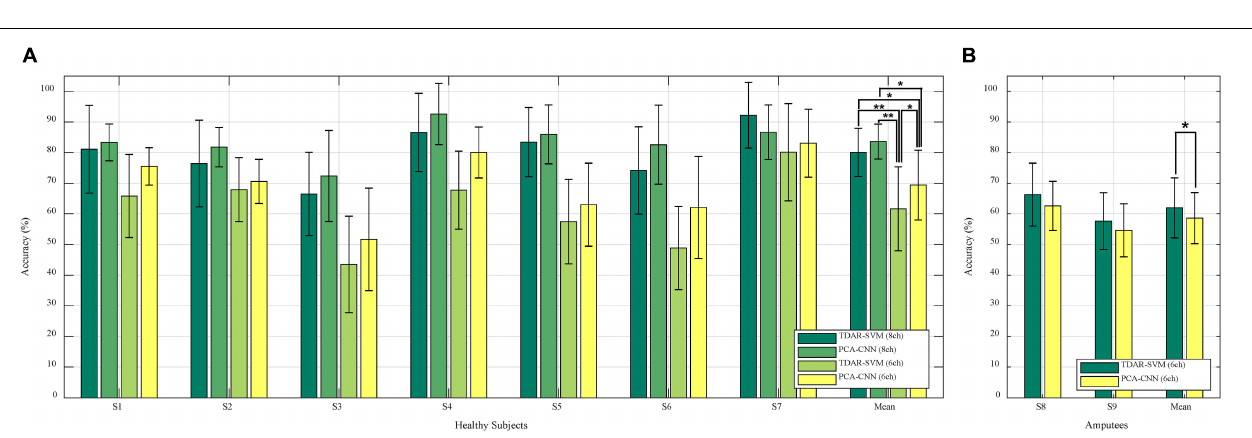
FIGURE 5 | Results of classifying reaching-to-grasping tasks with 10-fold cross-validation for (A) healthy subjects and (B) trans -radial and wrist amputees (* and ** means p -value < 0.05 and 0.01, respectively).